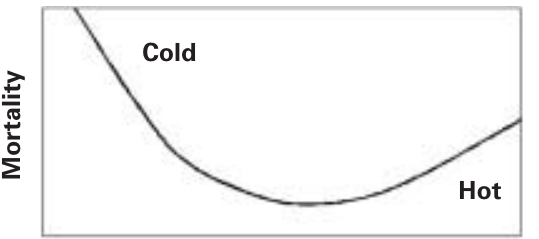
Figure 1 Schematic relation between mortality and atmospheric temperatures, adapted from Keatinge et al.